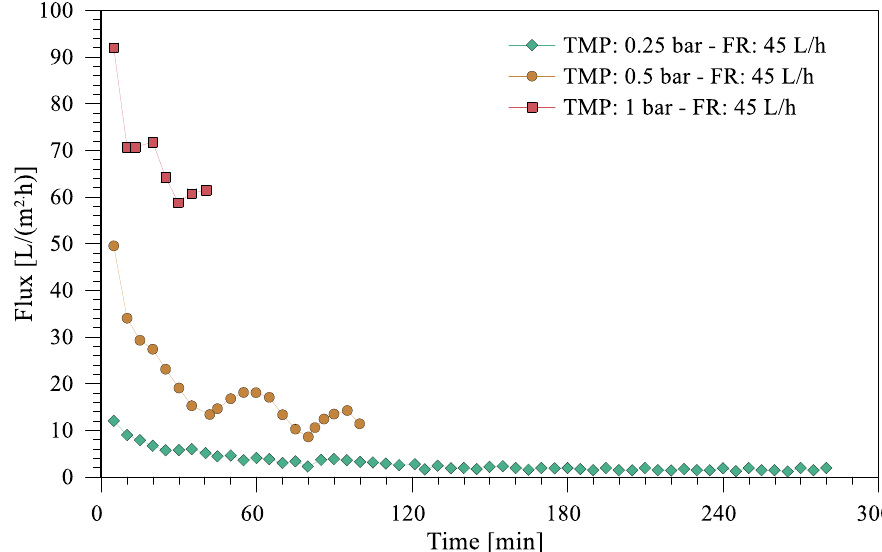
Figure 2. Flux over experimental time for ME experiments carried out at different pressures. FR represents flow rate.